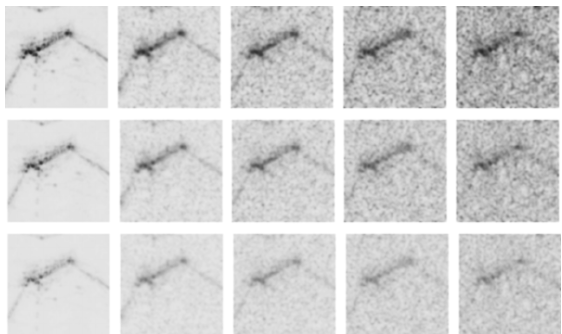
Figure 5. Pixel value inverted images of Figure 3b. The inversion effect occurs differently according to the distance between the sonar sensor and the dummy as like in the TDI-2017 and